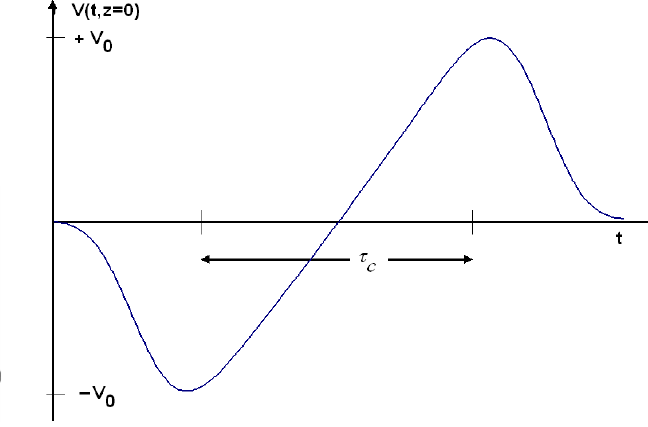
FIG. 1. Helical pulse line. FIG. 2. (Color) Voltage waveform at the helix input ( z (cid:3) 0